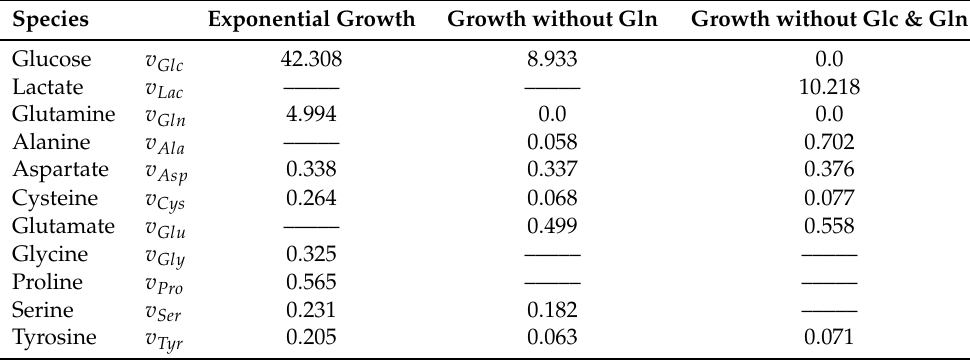
Table 2. Specific uptake rates ( µ M/d × 10 7 cell) Glucose, Lactate and non-essential AA.